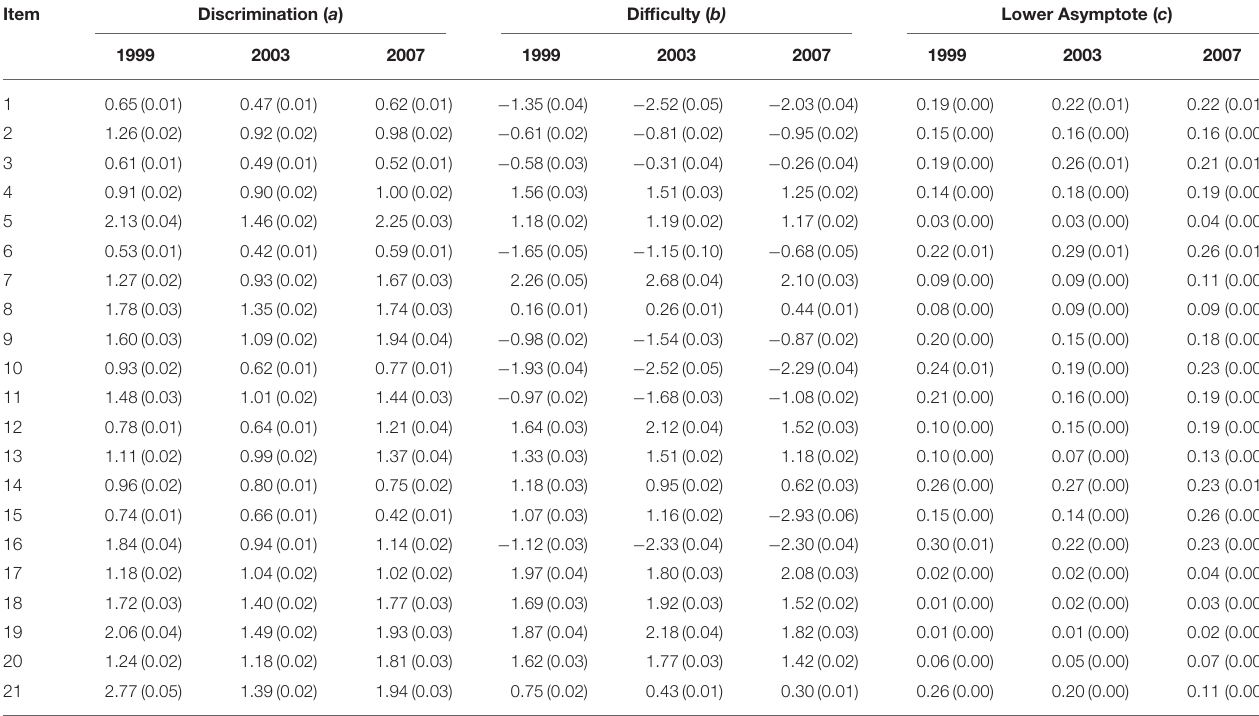
TABLE 1 | Item parameter estimates of the 21 trended anchor items in 1999, 2003, and 2007 TIMSS: Unidimensional 3PL IRT